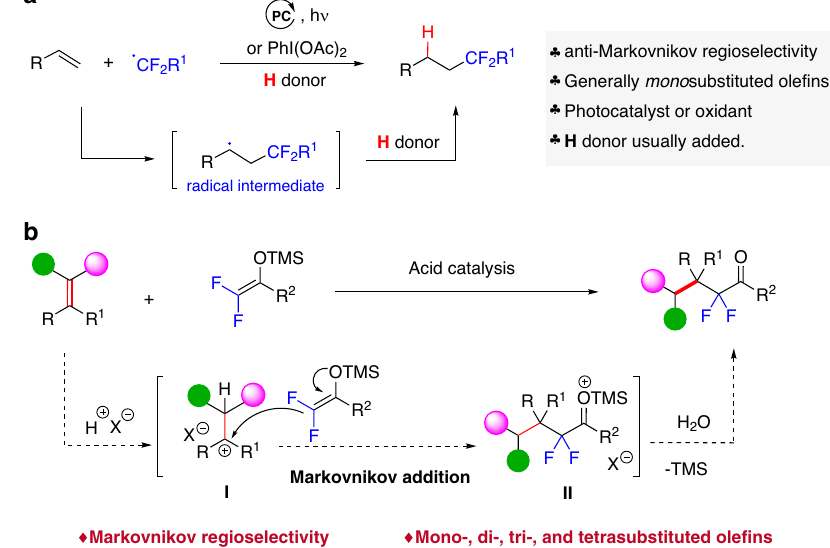
Fig. 1 State of the art and our proposed hydrodi fl uoroalkylation of simple alkenes. a Anti-Markovnikov alkene hydrodi fl uoroalkylation based on radical processes (well established). b Markovnikov alkene hydrodi fl uoroalkylation (this